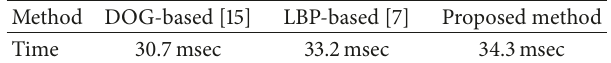
Table 8: Comparison of the processing